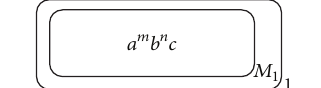
Figure 1: The initial configuration of P system for fraction reduc-